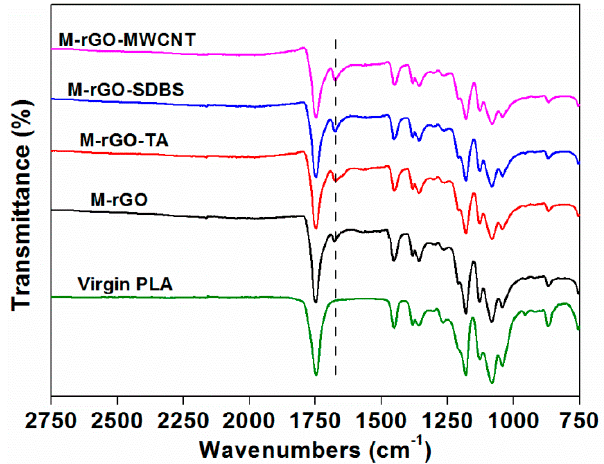
Figure 9. Fourier-transform infrared (FTIR) spectrum of the virgin polylactic acid (PLA) and the composites with the modifiers.